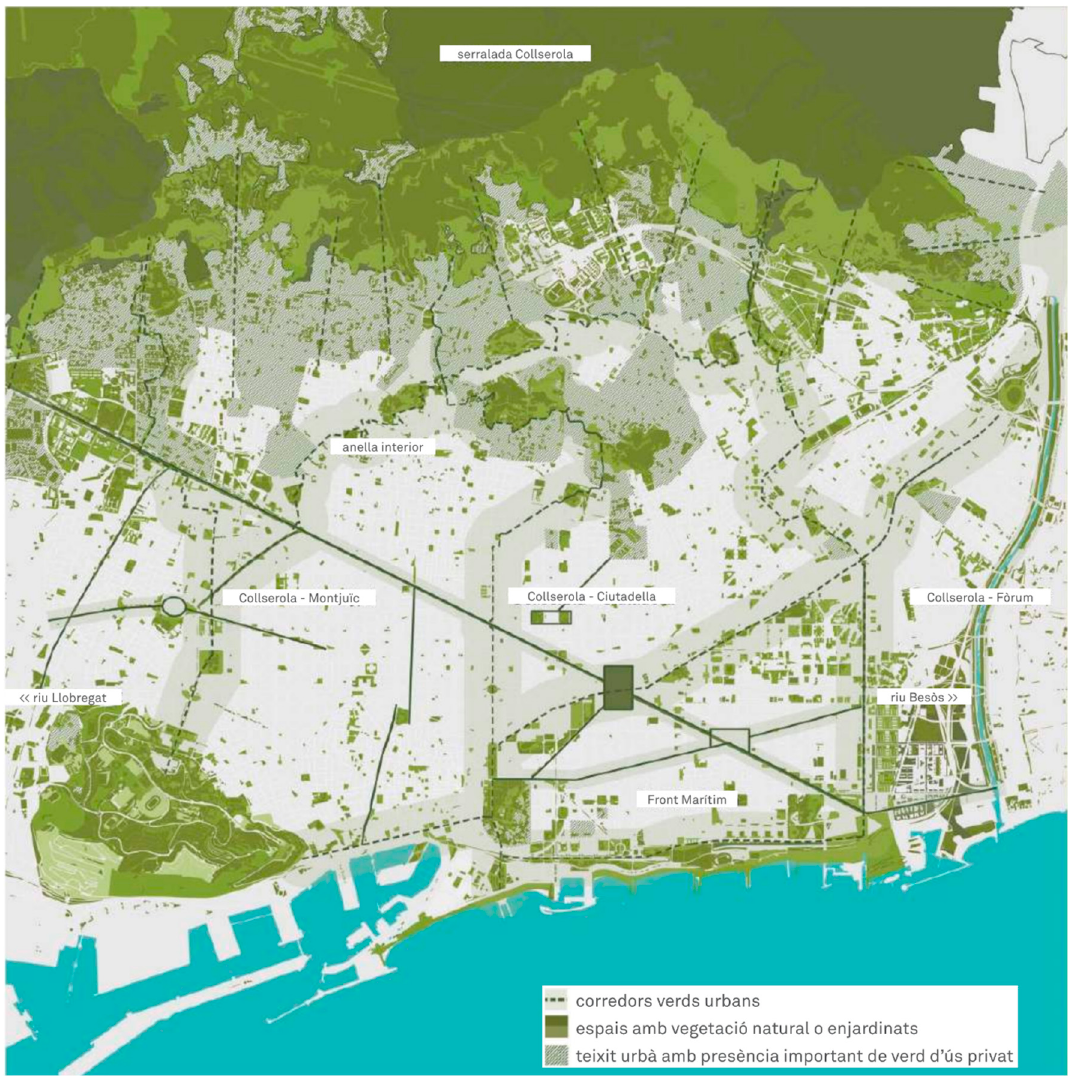
Figure 15. Green and Biodiversity Plan (2012–2020) showing urban green corridors, green areas and urban fabrics with significant presence of vegetation for private use Source: Ajuntament de Barcelona [52].